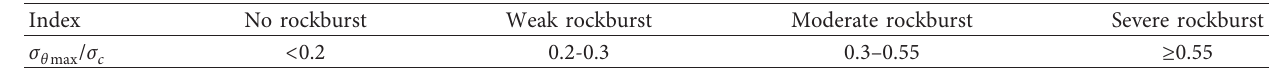
Figure 13: Response surface of the tunnel in key positions. (a) Roof. (b) Floor. (c) Spandrel. (d) Corner. (e) Sidewall. Table 5: Rockburst criterion from